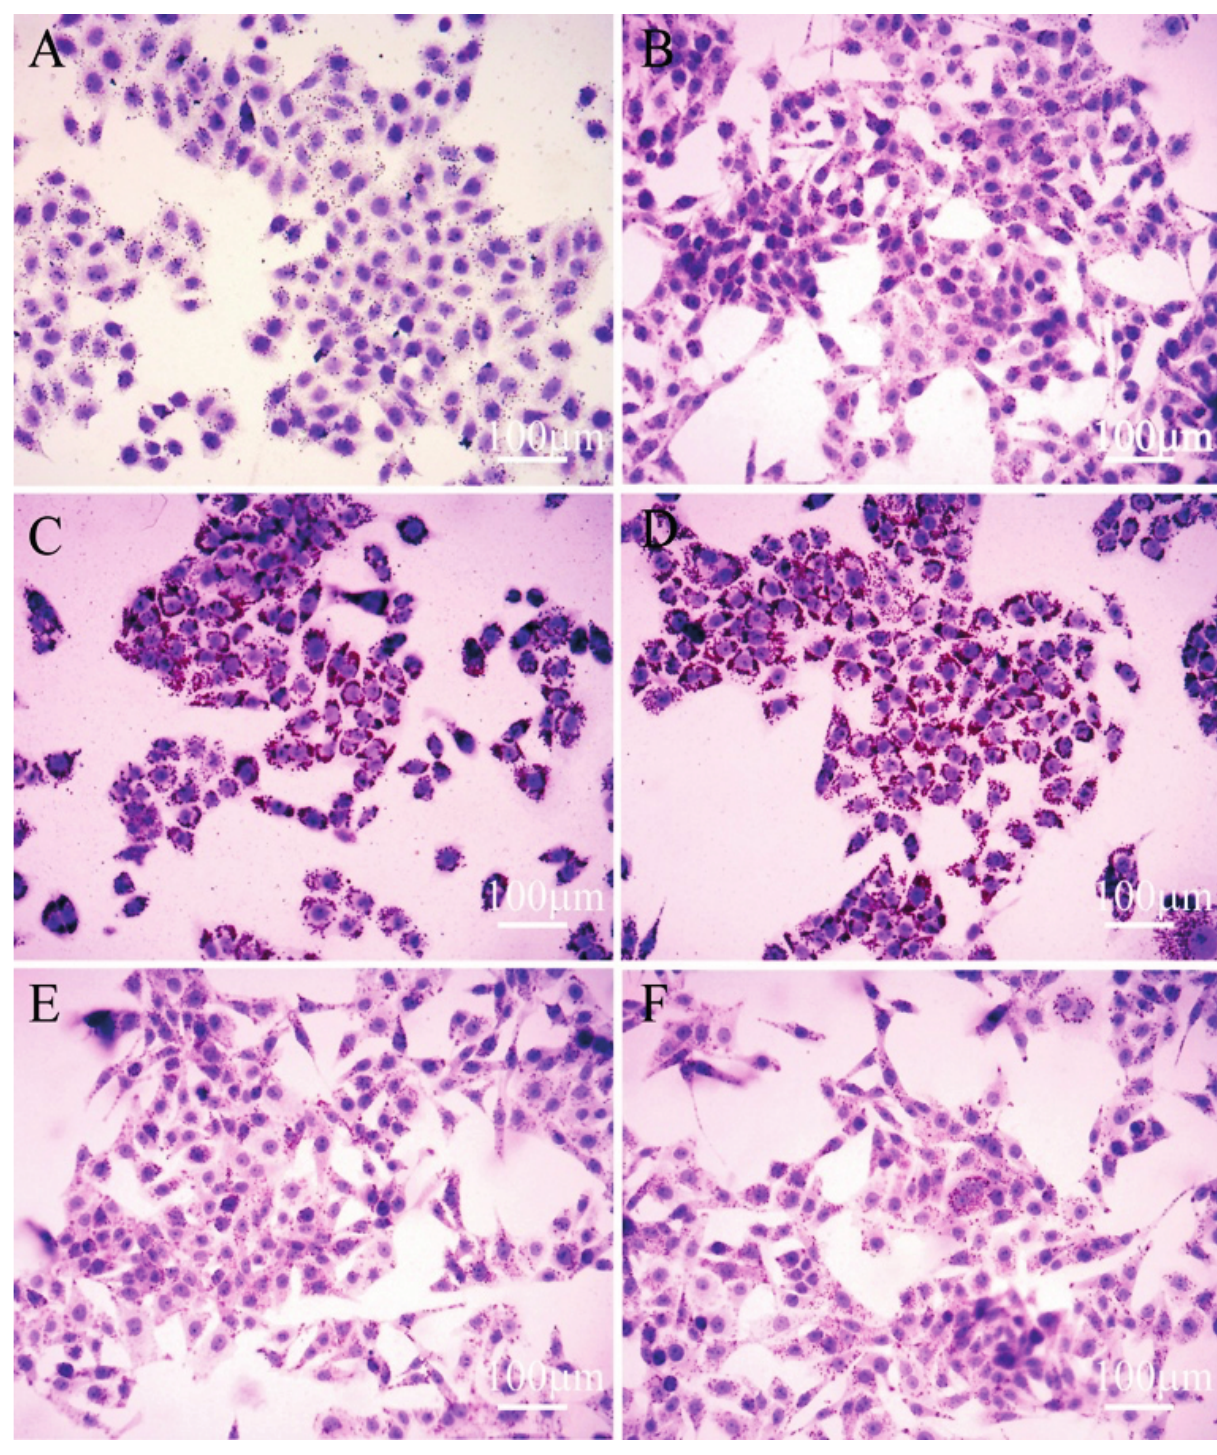
Figure 1: Oil Red O staining of the HepG2 cells in each group. A: Normal group; B: Fenofibrate group; C: model group; D: low dose group; E: medium dose group; F: high dose group. The hepatocytes in the model group were affected with orange lipid droplets of different sizes and diffuse orange lipid droplet fusion (scale bar 100